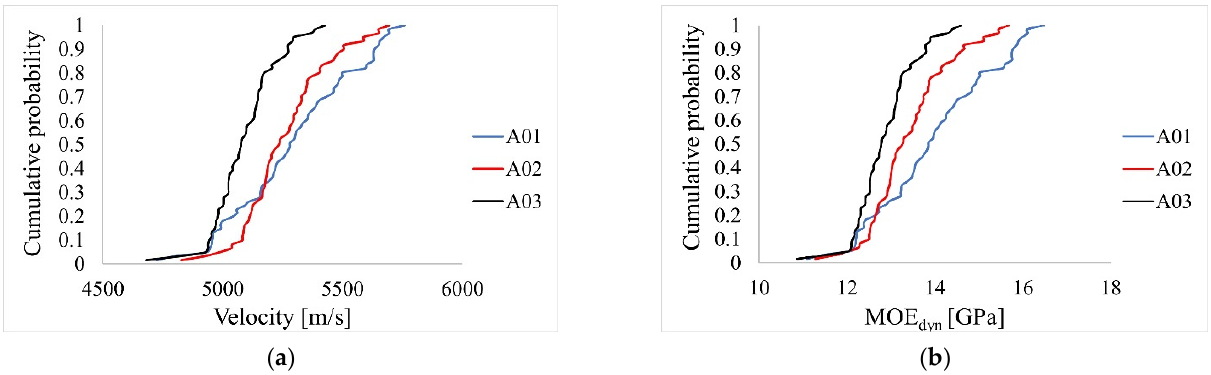
Figure 8. Empirical cumulative distribution function for Fakopp MS measurement parallel to the grain: ( a ) velocity, ( b ) MOE dyn .